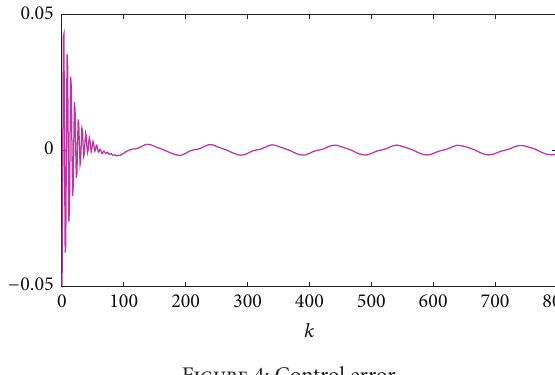
Figure 4: Control